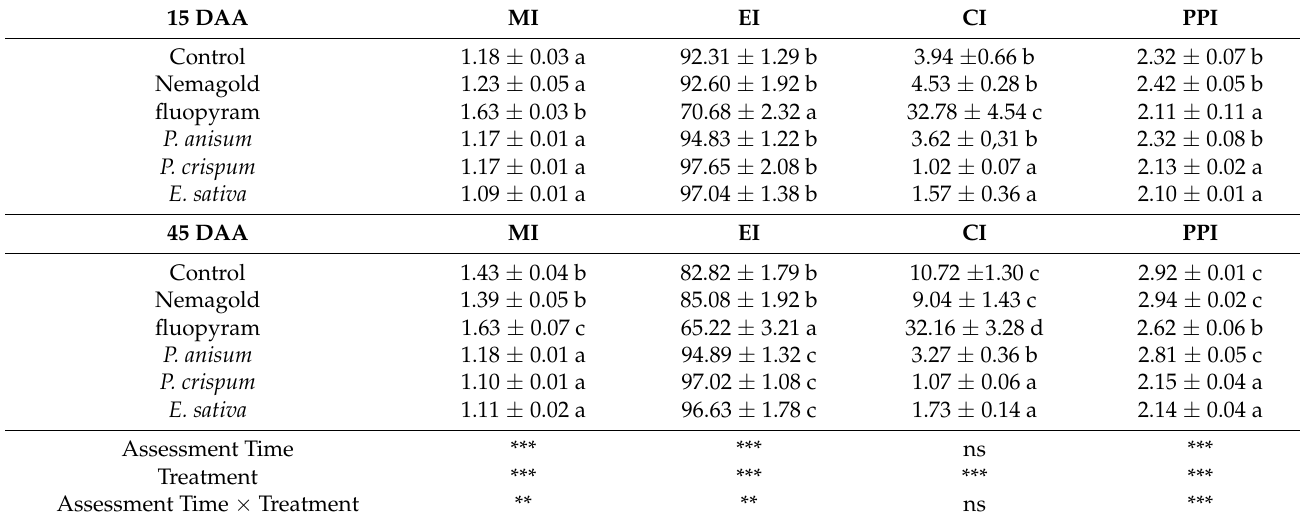
Table 1. Mean values ( ± st. error) of the Maturity Index (MI), Enrichment Index (EI), Channel Index (CI), and Plant Parasitic Index (PPI) under the different treatments for two assessment times, 15 and 45 days after application (15 DAA, 45 DAA). For each sampling occasion, within columns, means followed by the same letter are not significantly different (ANOVA and Fisher’s LSD post-hoc comparisons; **: p <0.01; ***: p < 0.001; ns: not significant, for all cases n =